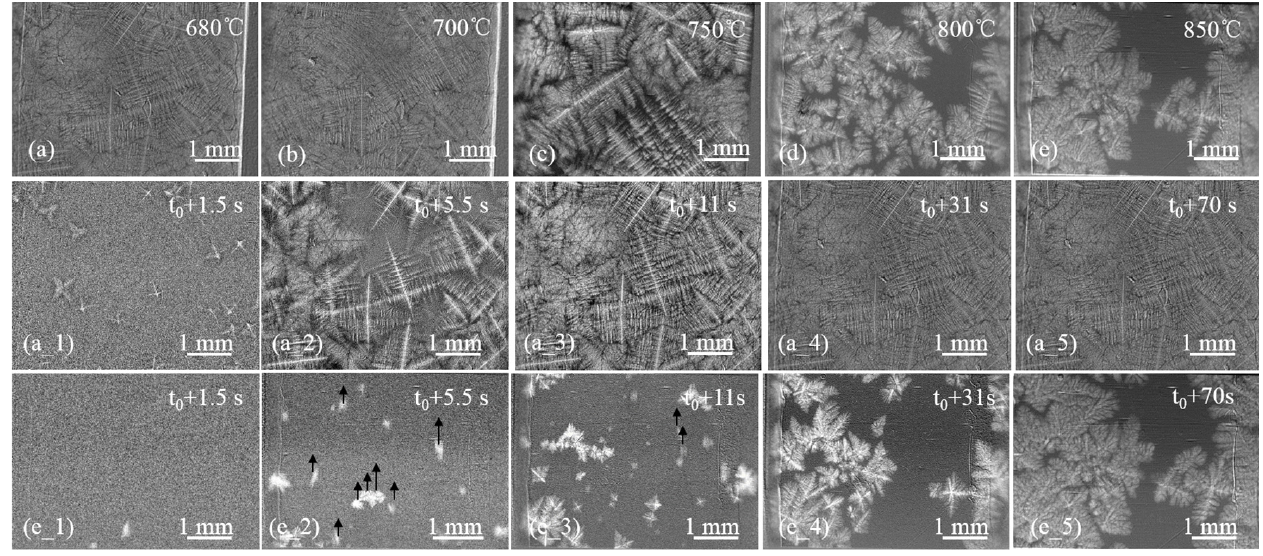
Figure 3. The microstructure of the 5 mm sample under different beginning temperatures. ( a ) 680 °C; ( b ) 700 °C; ( c ) 750 °C; ( d ) 800 °C; ( e ) 850 °C. Sequence of images showing the microstructural evolution of the 5 mm sample at a beginning temperature of ( a_ 1– a_5 ) 680 °C or ( e_1 – e_5 ) 850 °C. Black arrows indicate the floating